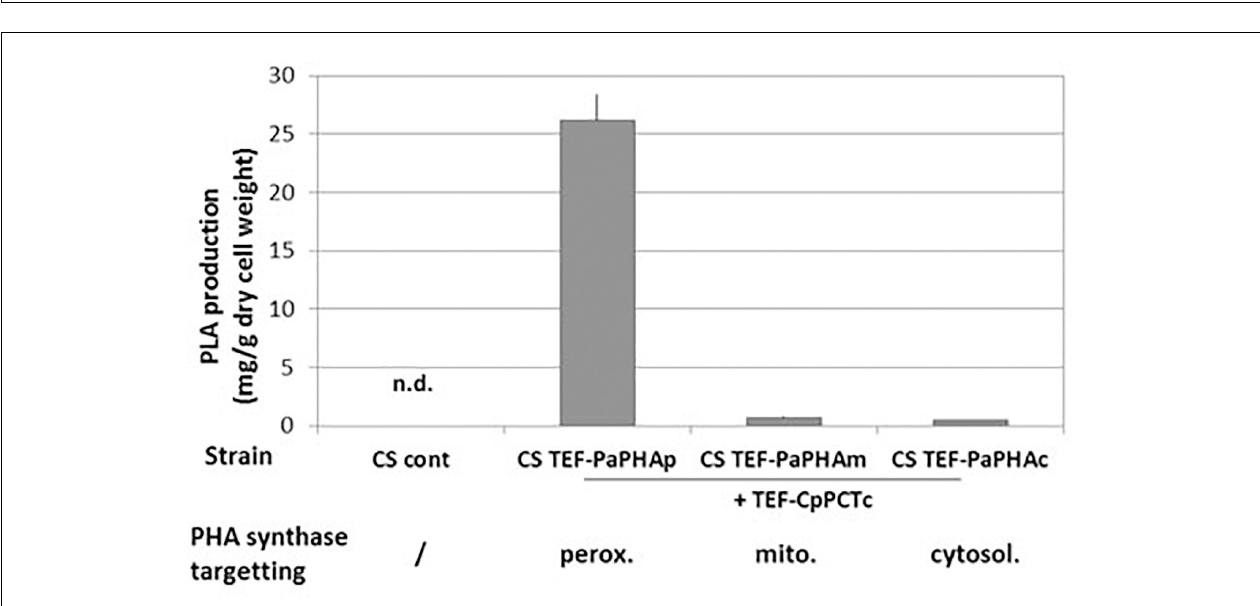
FIGURE 3 | Quantification of lactyl-CoA produced in strain expressing PCT protein from C. propionicum targeted to different subcellular compartments. Strains were grown for 24 h on minimum medium containing a mixture of 10 g/L of lactic acid. After a normalization, results were expressed as fold of CS TEF-CpPCTc strain result. For clarity purposes, only half error bars have been represented. N = 3 independent experiments.